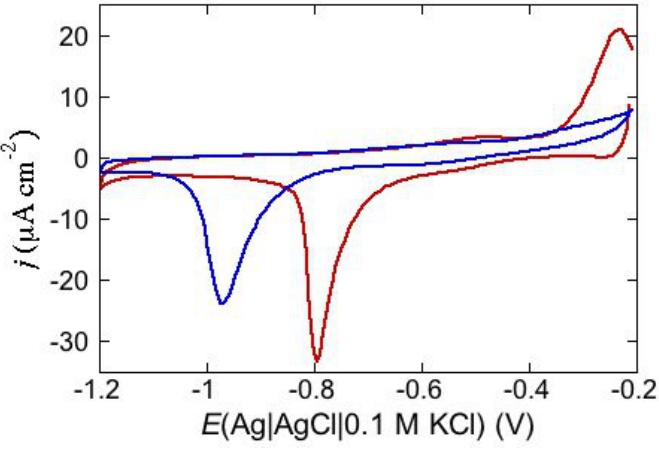
Figure 14. Cycle voltammogram of a DPTL/DOPS tBLM in a pH 7 buffer solution of 0.1 M KCl and 4 μ g mL − 1 DCD at a scan rate of 50 mV/s before ( blue curve ) and after addition of 4 × 10 − 5 M ZnSO ( red curve 4